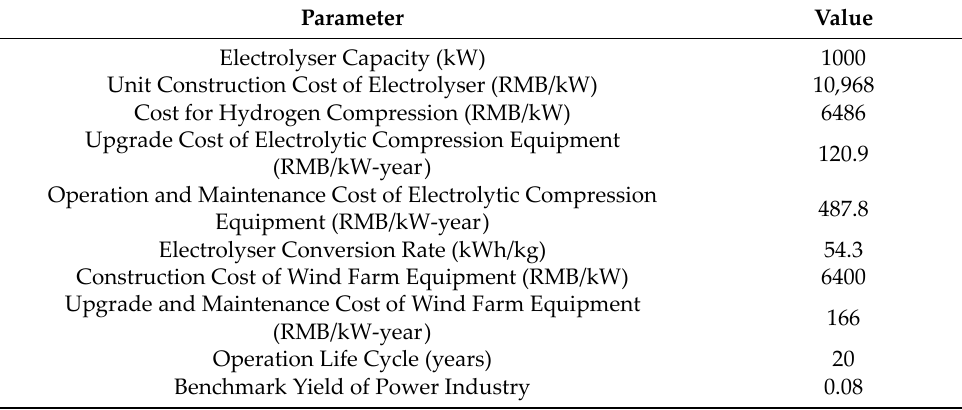
Table A1. List of operation parameters of wind power coupling hydrogen production system.